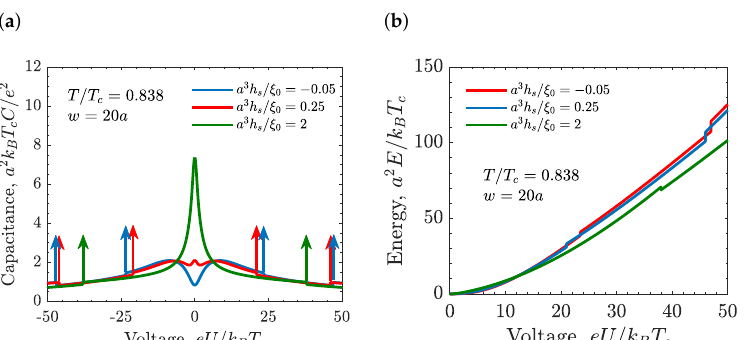
Figure 11. Influence of the ionophilicity on the capacitance and the stored energy of equally charged slit-shaped mesopore. ( a ) Differential capacitance. The vertical arrows indicate that capacitance di- verges at the capillary ionization transition. ( b ) Stored energy in the pore as a function of the applied voltage. In all the plots, the chemical potential µ / k B T c = − 4.57, the slit width w = 20 a , and tem- perature T / T c = 0.838. The blue lines correspond to ionophilicity a 3 h s / ξ 0 = − 0.05 (ionophobic electrodes), red lines to a 3 h s / ξ 0 = 0.25 (mild-ionophilic electrodes), and green lines to a 3 h s / ξ 0 = 2 (strongly ionophilic electrodes); a is the ion diameter and ξ 0 the bare correlation length. For common values of the ion diameter a = 0.7 nm and room temperature for T c , the various units are: thermal voltage e / k B T c ≈ 26 mV for voltage, thermal electric capacitance e 2 / ( k B T c a 2 ) ≈ 620 µ Fcm − 2 for capacitance, k B T c / a 2 ≈ 0.84 mJcm − 2 ≈ 0.23 nWcm − 2 for energy, and e / a 2 ≈ 2 e nm − 2 ≈ 32 µ Ccm −